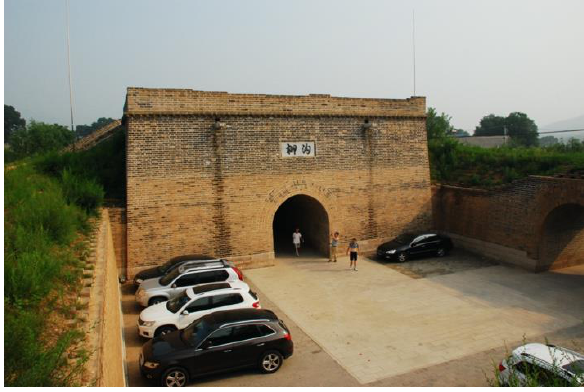
Figure 10. Drainage system of the north town gate.